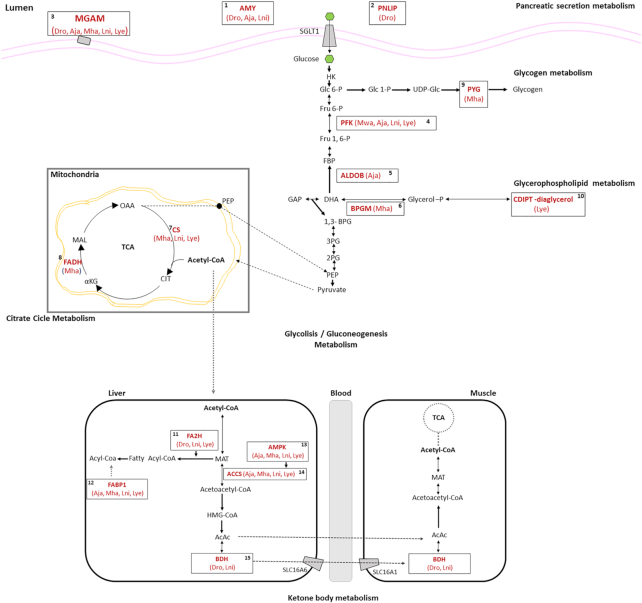
A subset of genes under positive selection (in red boldface) that are involved in glucose and ketone metabolism in the frugivorous (Aja: A. jamaicensis) and nectar-pollen bats (Mha: M. harrisoni; Lni: L. nivalis; and Lye: L. yerbabuenae). The diagram also identifies adaptative signals for some genes in the vampire D. rotundus (Dro) and the insectivore M. waterhousii (Mwa). The diagram is based on the KEGG metabolic pathways database and a review of the literature (see gene and protein abbreviations in Supplementary Table S8).